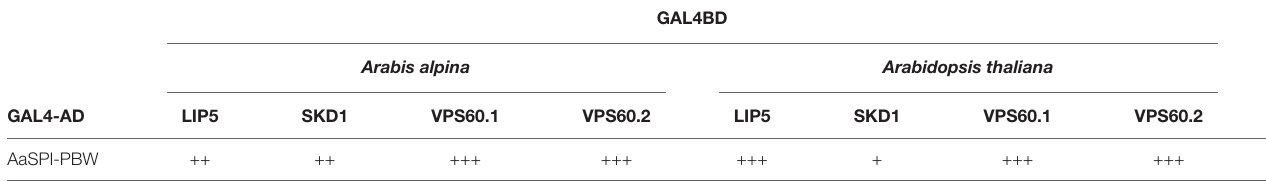
TABLE 4 | Yeast two-hybrid interaction between AaSPI-PBW and ESCRT components.